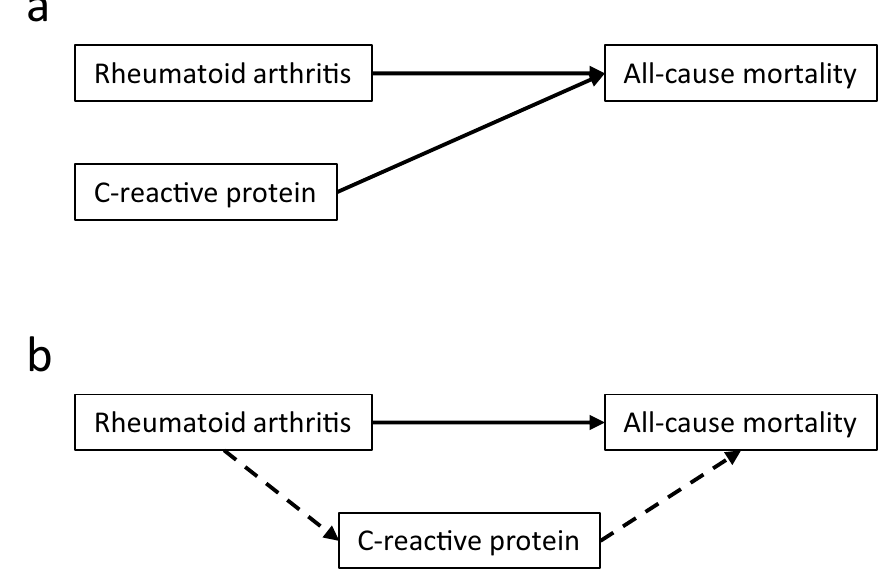
Figure 2. Analytical models. Panel a: In Cox regression, the independent associations with all-cause mortality of each of the explanatory variables presence of rheumatoid arthritis and C-reactive protein concentration ≥ 3 mg/L were investigated. Panel b: In the mediation analysis, the direct association with all- cause mortality of rheumatoid arthritis was investigated